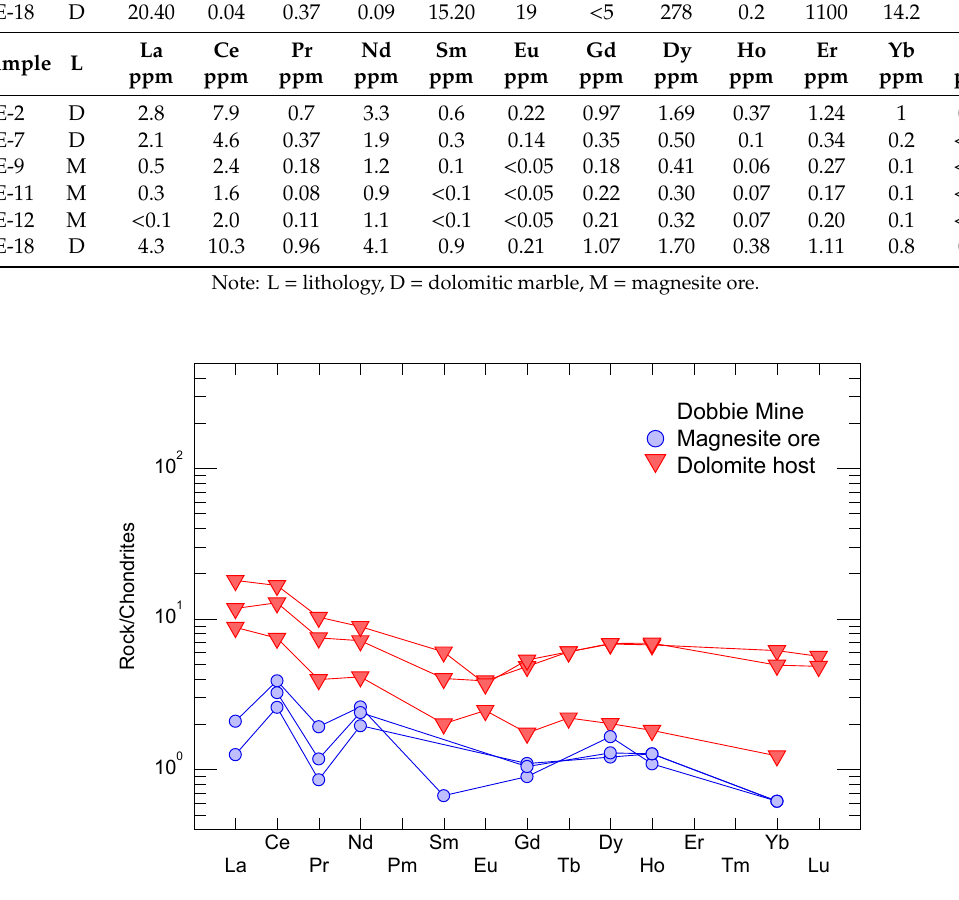
Figure 8. Rare Earth Element composition of the magnesite ore and dolomitic marble from the Dobbie mine, normalized to chondrite [26].